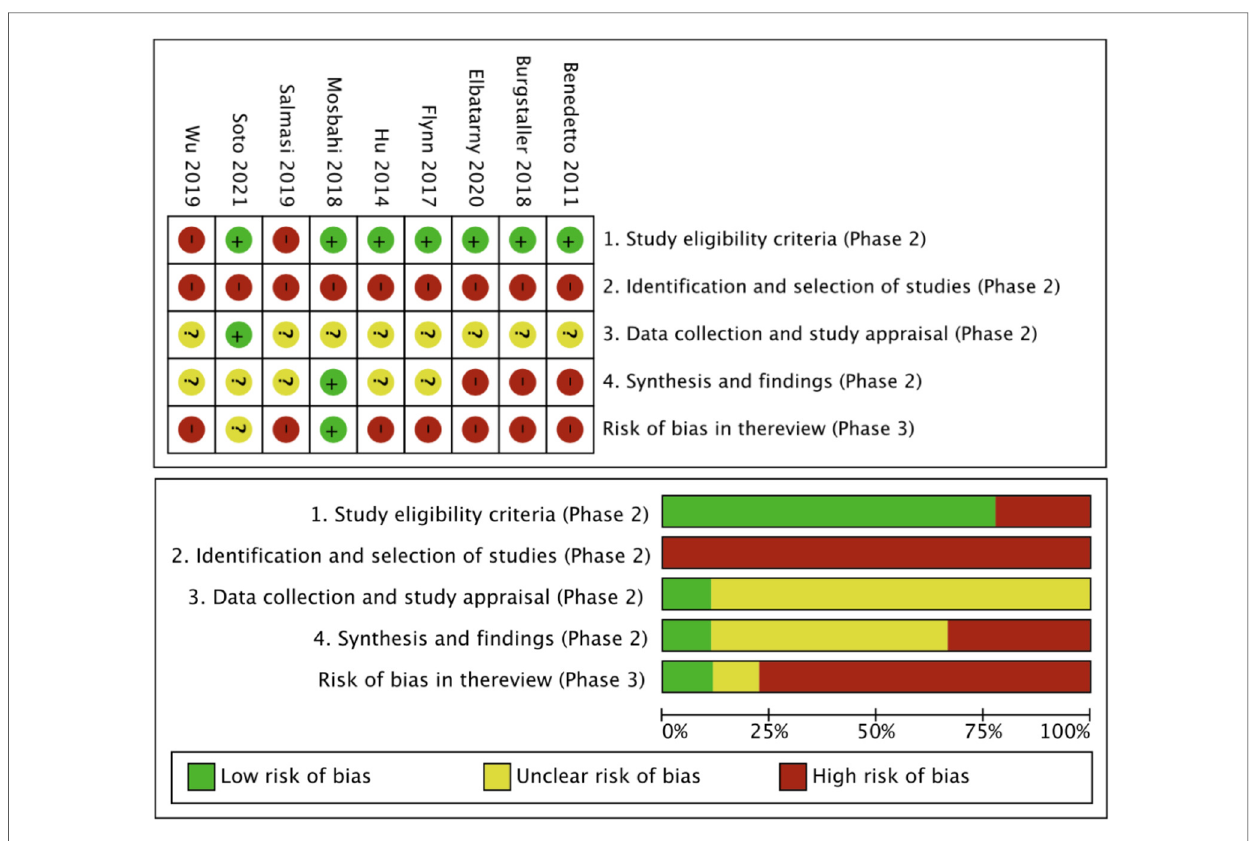
FIGURE 4 Visual analysis results of Risk of Bias in Systematic